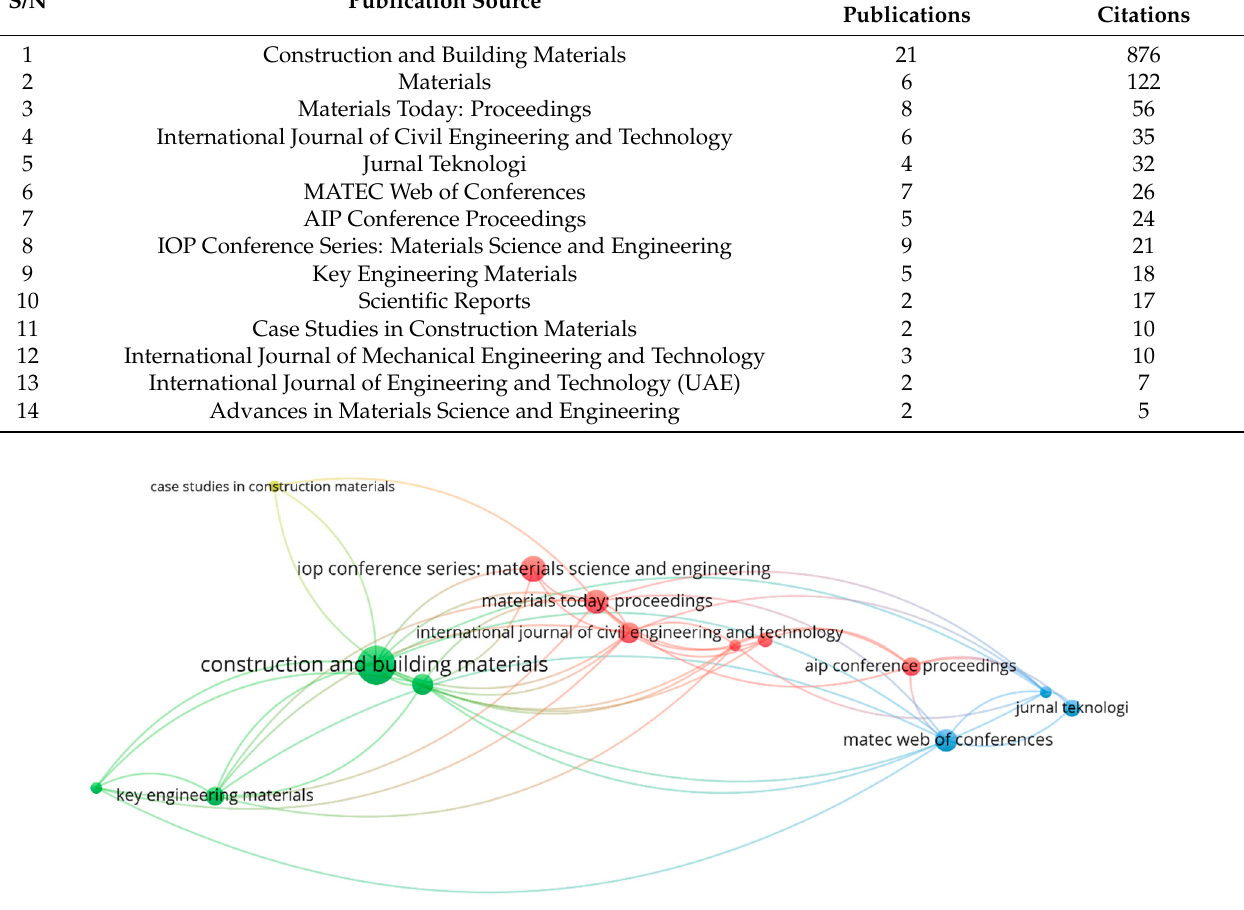
Figure 7. Scientific visualization of publication sources in the related research area.